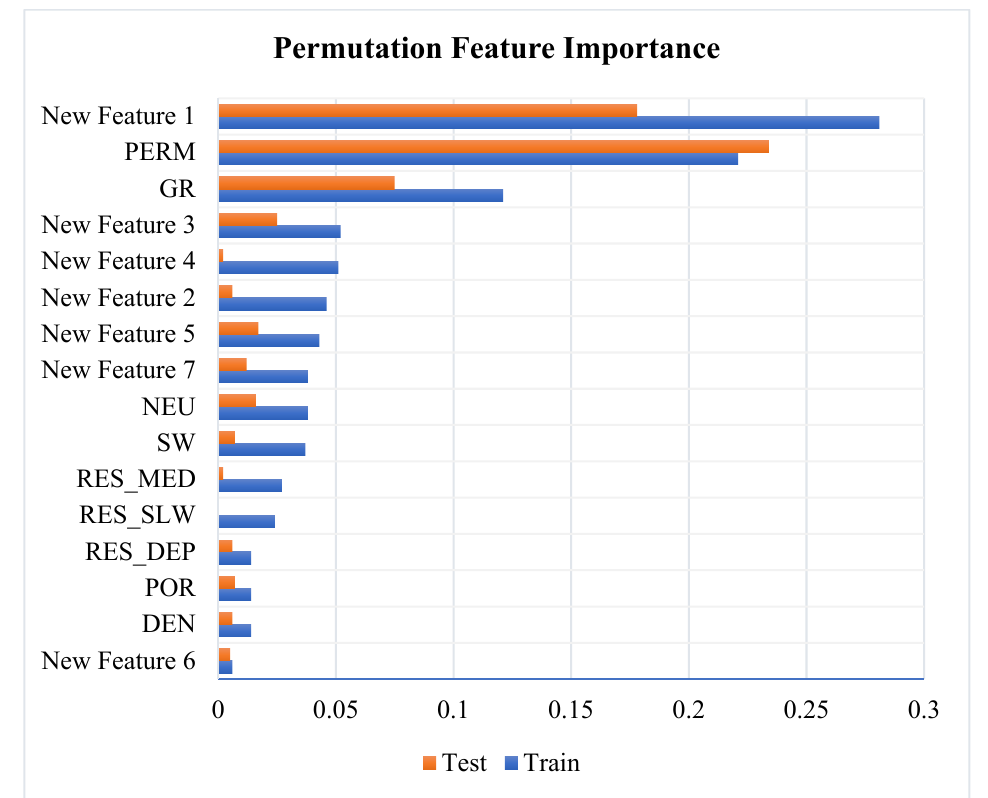
Figure 12. Permutation feature importance on all input variables for T 2 LM prediction.